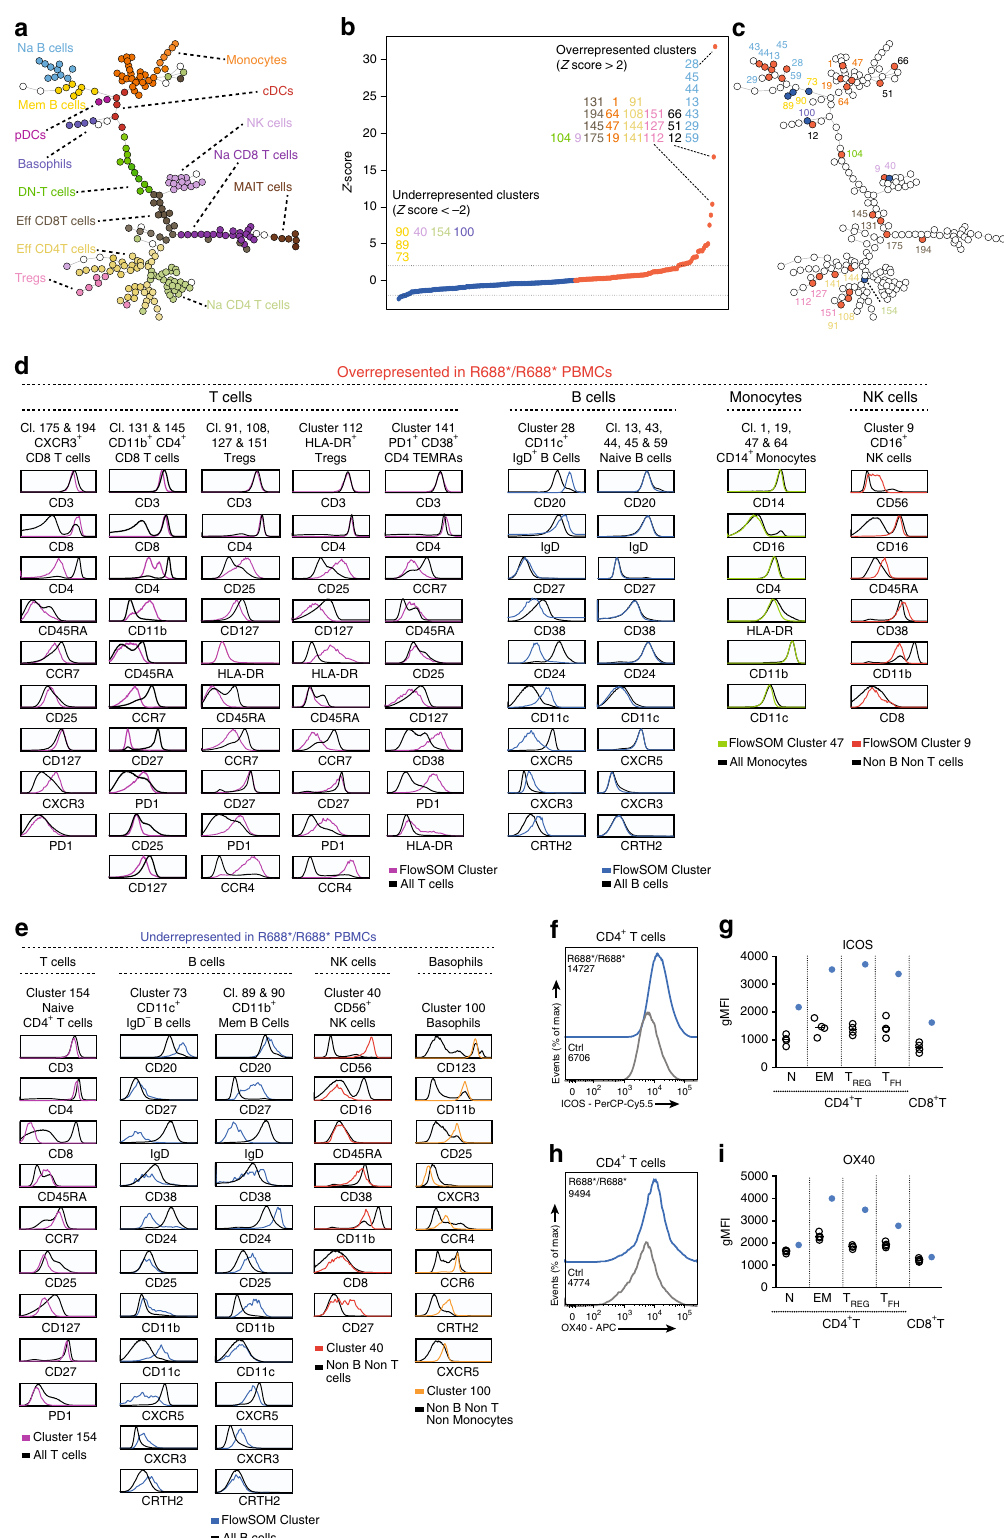
regulatory T cells (Tregs) and CD16 + NK cells were over- represented in the R688*/R688* patient whereas clusters identi- fi ed as memory B cells, basophils, naive CD4 + T cells and CD56 + NK cells were underrepresented (Fig. 2c). An additional three clusters containing cellular debris (cluster 12) or doublet cells (clusters 51 and 66) appeared overrepresented in